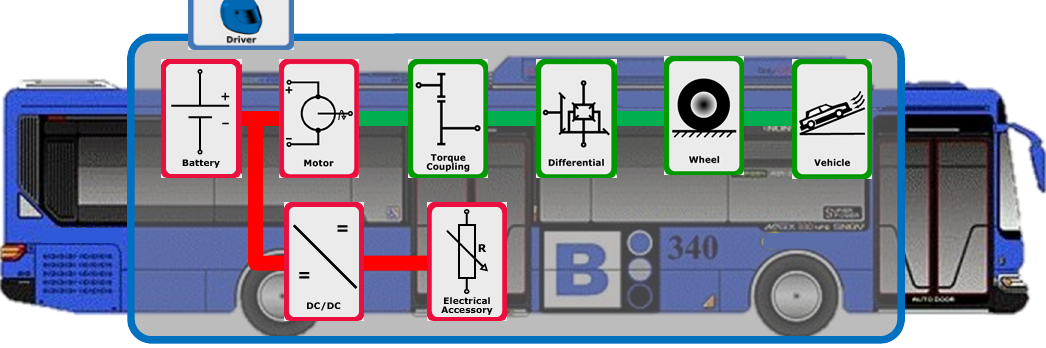
Figure 3. Energy model built with Autonomie from ANL.